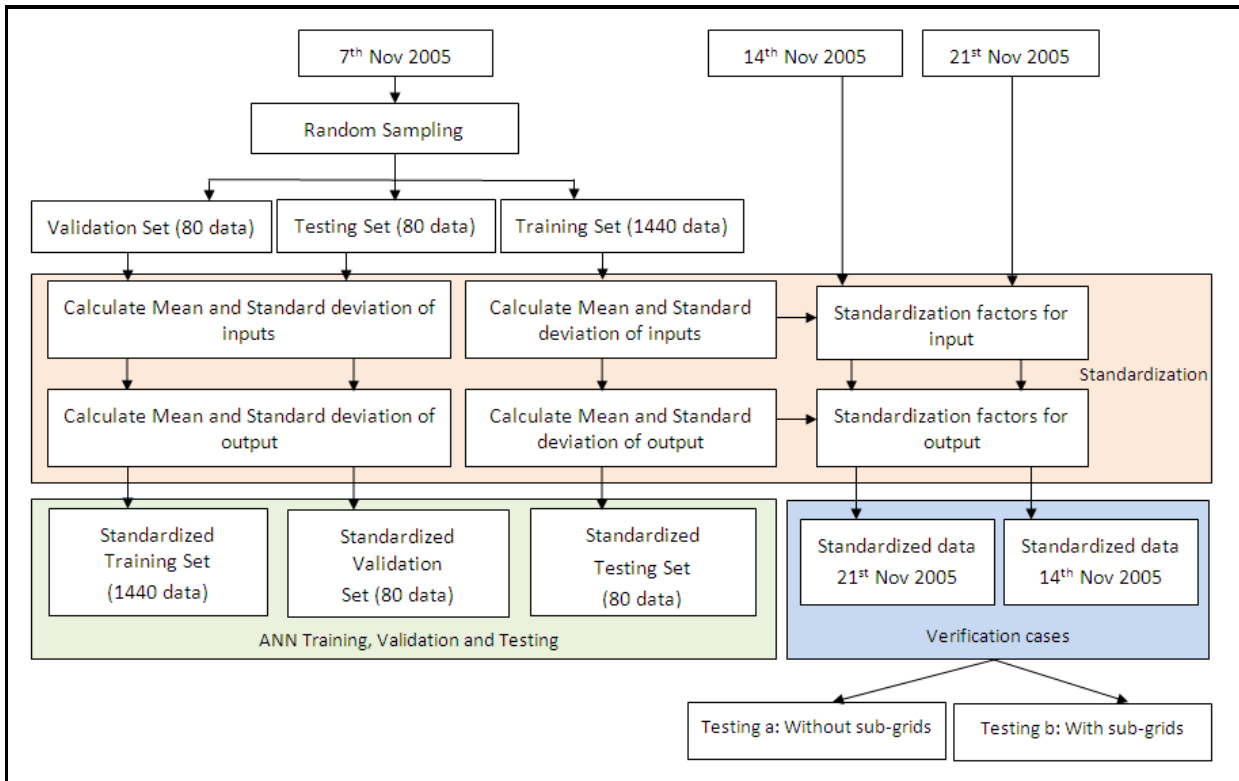
Figure 7 . The standardization factors from the training data that were used for the verification